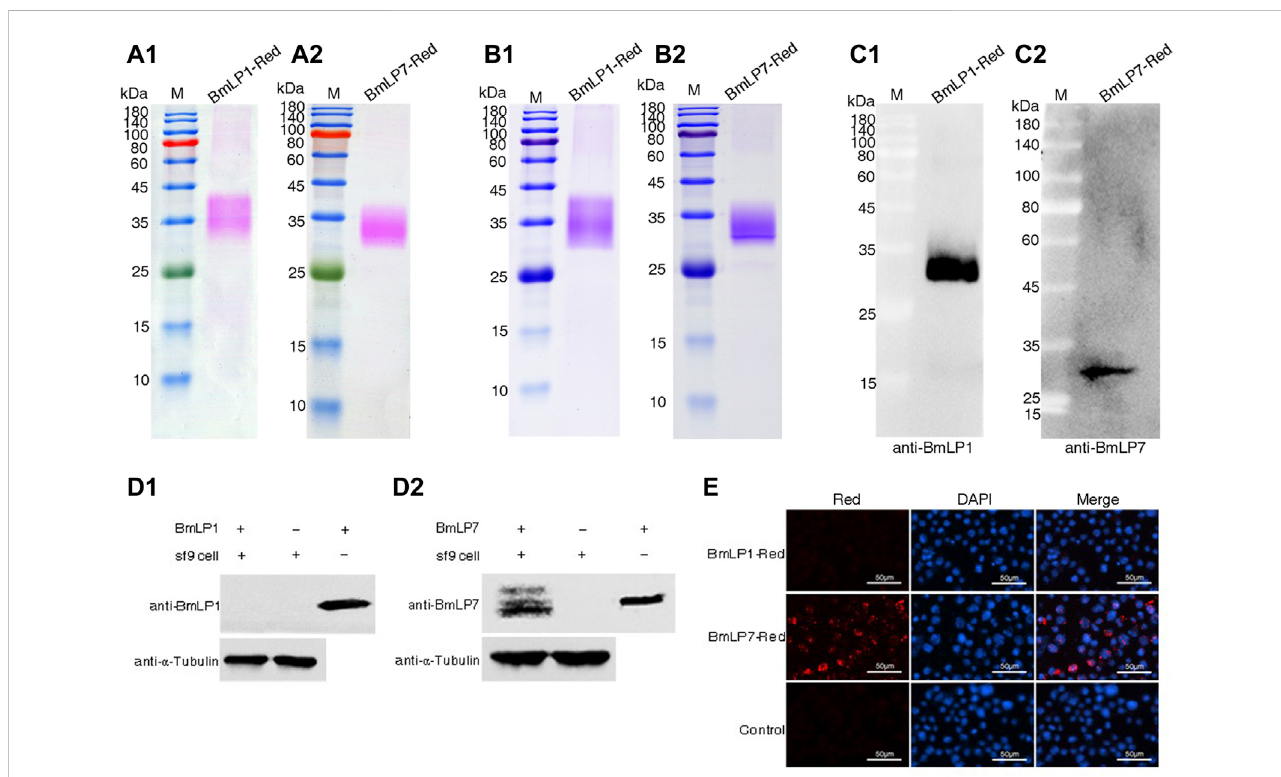
FIGURE 2 Analysis of BmLP1 and BmLP7 entering sf9 cells. (A) Direct observation of BmLP1-Red (A1) and BmLP7-Red (A2) after SDS-PAGE. (B) Coomassie brilliant blue staining detection of the BmLP1-Red (B1) and BmLP7-Red (B2) after SDS-PAGE. (C) Detection of BmLP1-Red (C1) and BmLP7-Red (C2) using western blotting by anti-BmLP1 and BmLP7 rabbit antibody (1:10,000), respectively, and HRP-conjugated goat anti-rabbit IgG (H + L) antibody (1:10,000). (D) DetectionofBmLP1 (D1) andBmLP7(D2) proteins entering sf9cells. Lane1,sf9cellslysate afterincubationwith BmLP1 orBmLP7;Lane2, sf9cellslysate without BmLP1 or BmLP7 protein; Lane 3, puri fi ed BmLP1 or BmLP7 protein; α -tubulin, used as an internal reference. (E) Fluorescence signal detection of BmLP1-Red and BmLP7-Red entering sf9 cells. Red images indicate cells observed under the red fl uorescence-emitting light channel. DAPI images indicate cells observed with DAPI nuclear counter stain. Merged images show a combination of Red and DAPI images. Control, sf9 cells incubated with